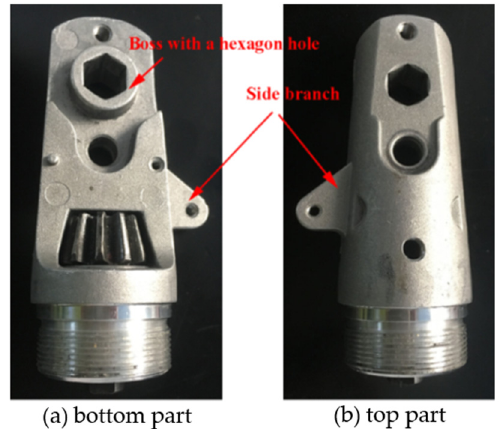
Figure 1. The AA6063 aluminum alloy component with complex shape: ( a ) bottom part, and ( b ) top part. Table 1. The simulation parameters for one-step cold orbital forming base.